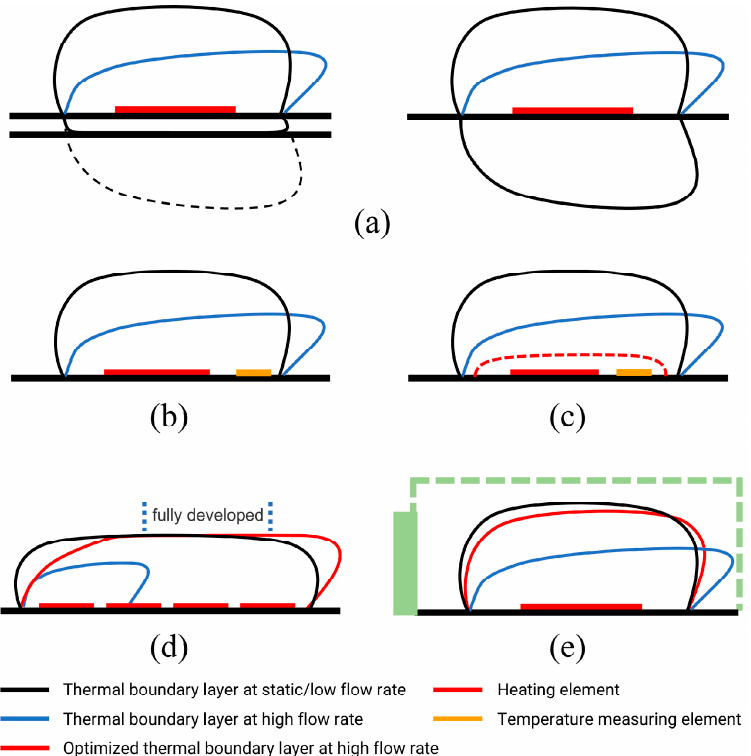
Figure 1. Schematic of the methods to reduce the flow rate interference. ( a ) Deep and shallow groove structure, ( b ) optimized sensing element, ( c ) AC excitation and the thermal sublayer, ( d ) multiple hot wires, ( e ) barrier or enclosed space.